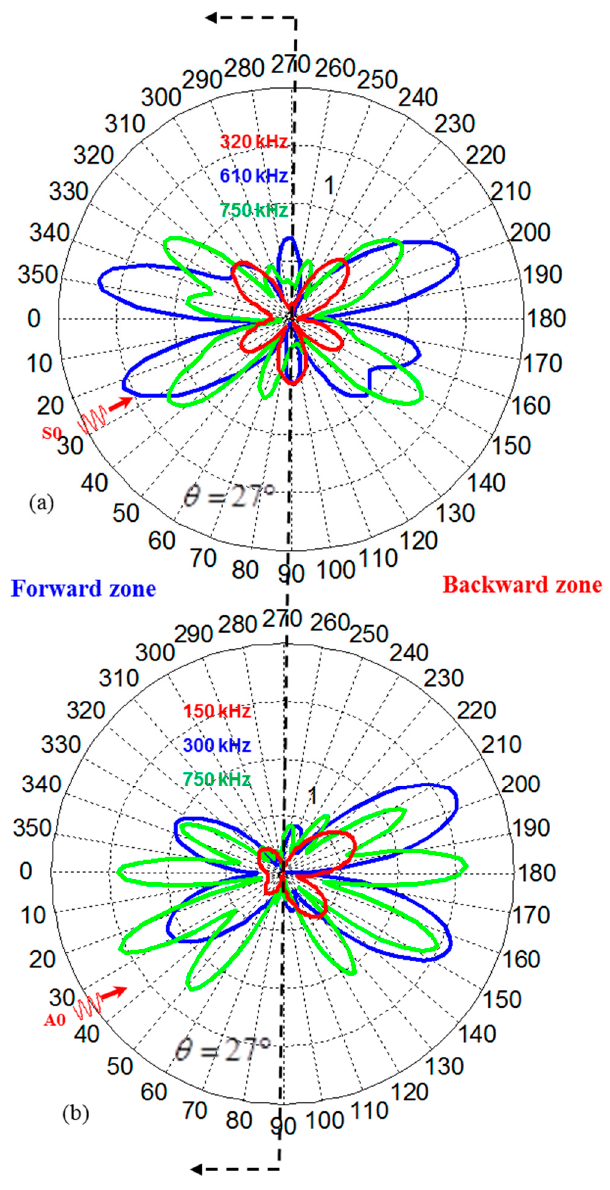
WDIC ; ( b ) WDIC at different frequencies. Figure 9. Azimuthal variation of ( a ) WDIC S0_S0 A0_A0 S0_S0 ; ( b ) WDIC A0_A0 at different